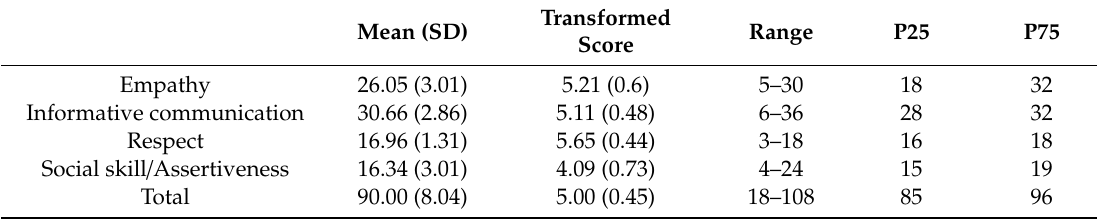
Table 4. Descriptive statistics of